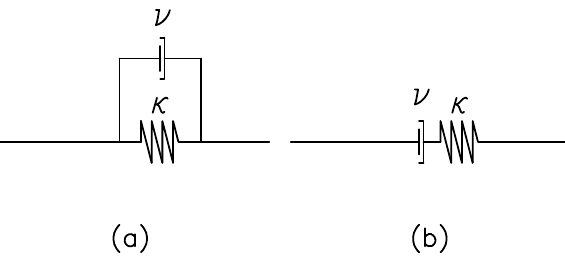
Figure 2. The two types of viscous materials: (a) for the Kelvin– Voigt model and (b) for the Maxwell model. ( κ = spring constant and υ = coefficient of